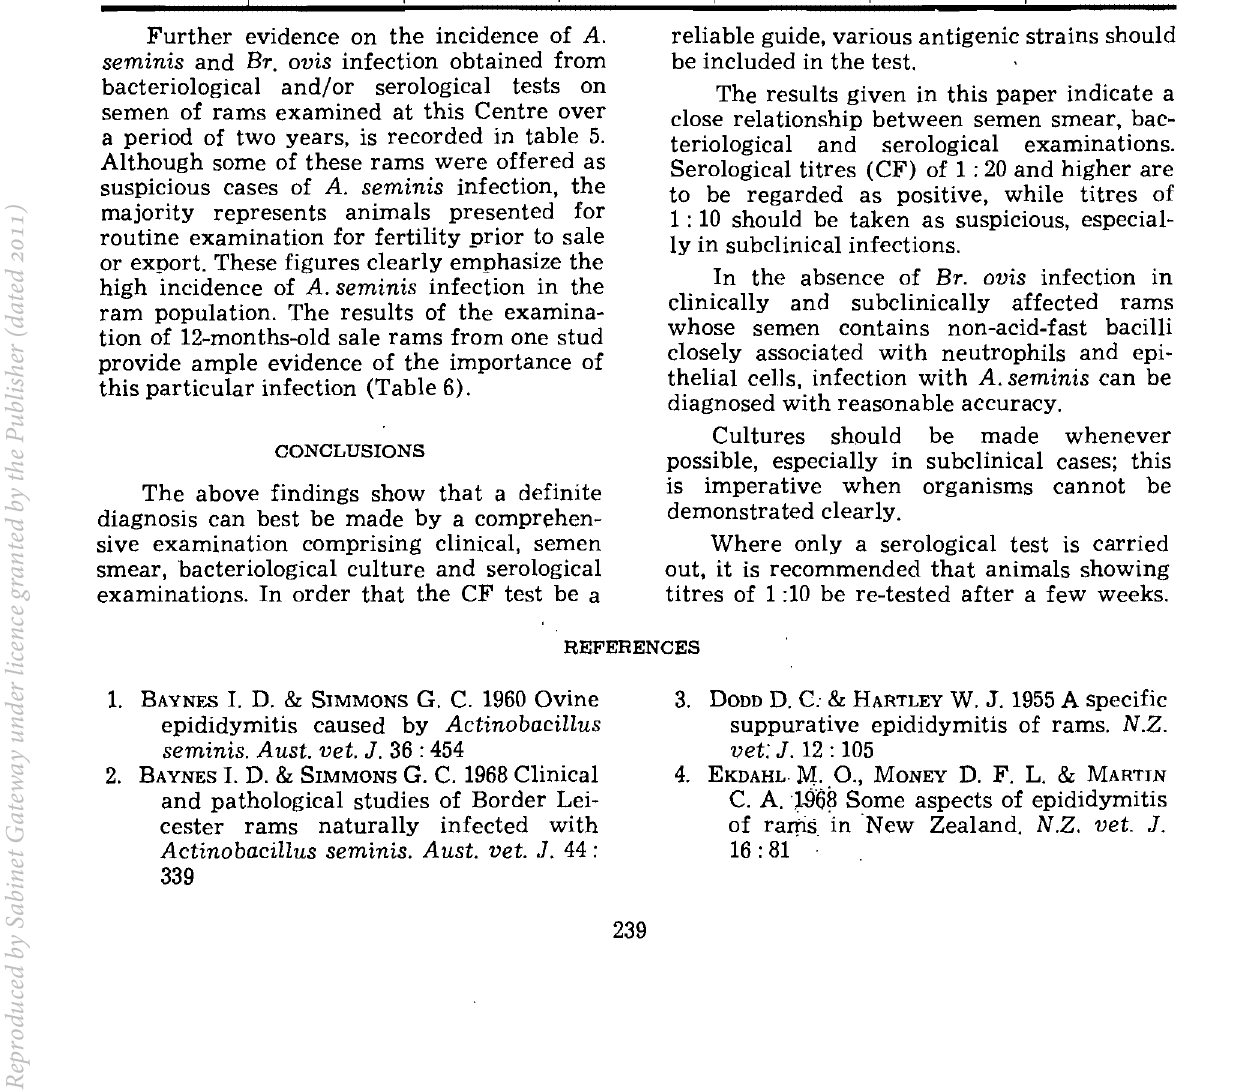
Table 6: RESULTS OF EXAMINATIONS OF SALE RAMS FROM A SINGLE STUD No.